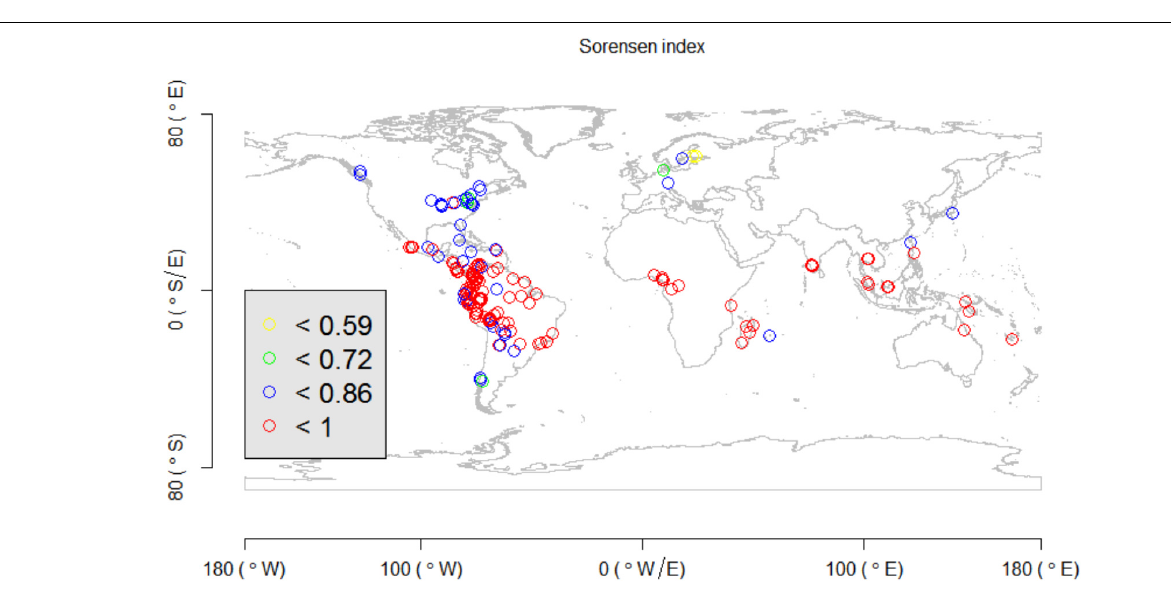
FIGURE 6 | Sorensen index for global Gentry forest